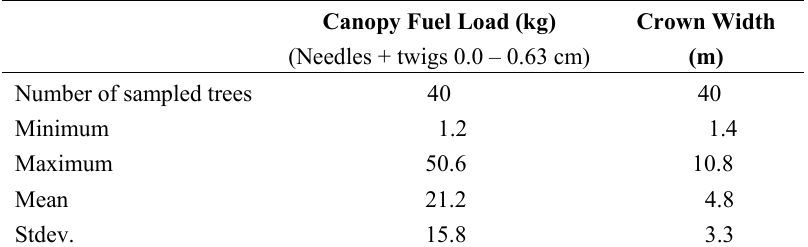
Table 1. Descriptive statistics of Aleppo pine sampled